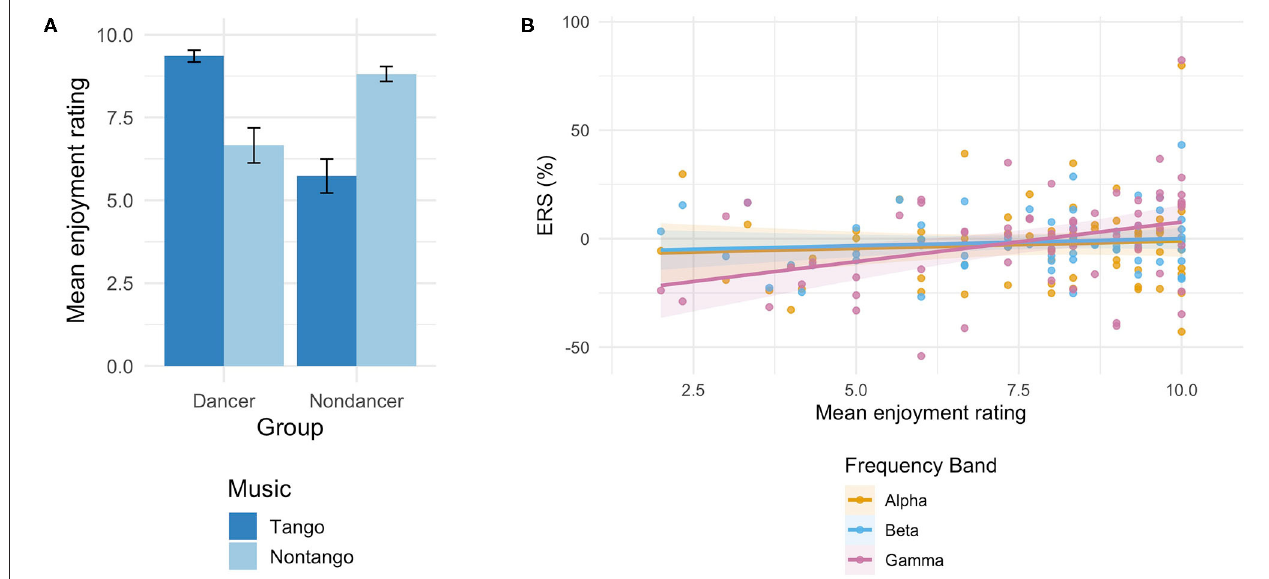
FIGURE 3 | (A) Mean enjoyment ratings of music (1 = no enjoyment, 10 = most enjoyable) by music condition in each participant group. Error bars represent standard error of the mean. Tango condition served as dancers’ own music, while non-tango condition served as non-dancers’ own music. (B) Estimated rating scores for all tango and non-tango music as a linear function of ERS in all participants for the alpha, beta, and gamma bands. Shaded regions indicate confidence intervals at each estimate. A linear mixed regression excluding extreme values ( ± 3 SD from mean ERS ) did not alter the findings [Main effect of ERS p -values in original analysis: p = 0.991 (alpha), p = 0.695 (beta), p = 0.011 (gamma); Main effect of ERS p -values in analysis without outliers: p = 0.388 (alpha), p = 0.888 (beta), p = 0.012